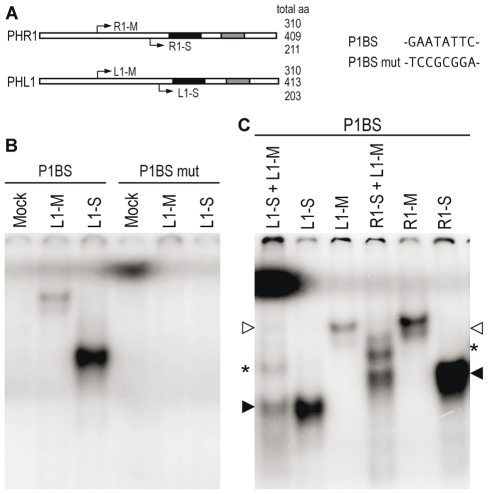
DNA-binding and dimerisation properties of PHL1.(A) Diagram showing the PHR1 and PHL1 proteins, including MYB (black) and the predicted coiled-coil domains (grey), indicating the start of the N-terminally truncated versions of PHR1 (medium-length PHR1, R1-M; short PHR1, R1-S) and PHL1 (medium-length PHL1, L1-M; short PHL1, L1-S) used (left). The core sequence of the oligonucleotide containing the PHR1 binding sequence (P1BS) and the mutated version (P1BS mut) are shown (right). (B) EMSA showing binding to P1BS, but not to its mutant version, of N-terminal forms of PHL1. (C) PHL1 dimerisation determined by EMSA with the two N-terminally truncated versions of PHL1 and PHR1. Proteins were translated in vitro alone or in combination. Arrows show the position of the homodimers formed with short (closed arrows) and medium-length proteins (open arrows); asterisks show the position of homo- or heterodimers formed by the combination of short and medium-length proteins. A mock translation mixture (Mock) was used as control.